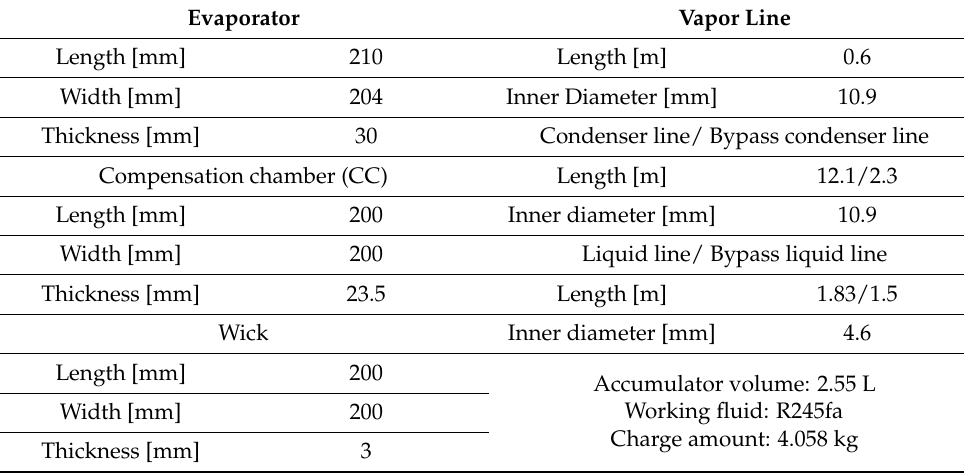
Table 1. Configuration of wick-type